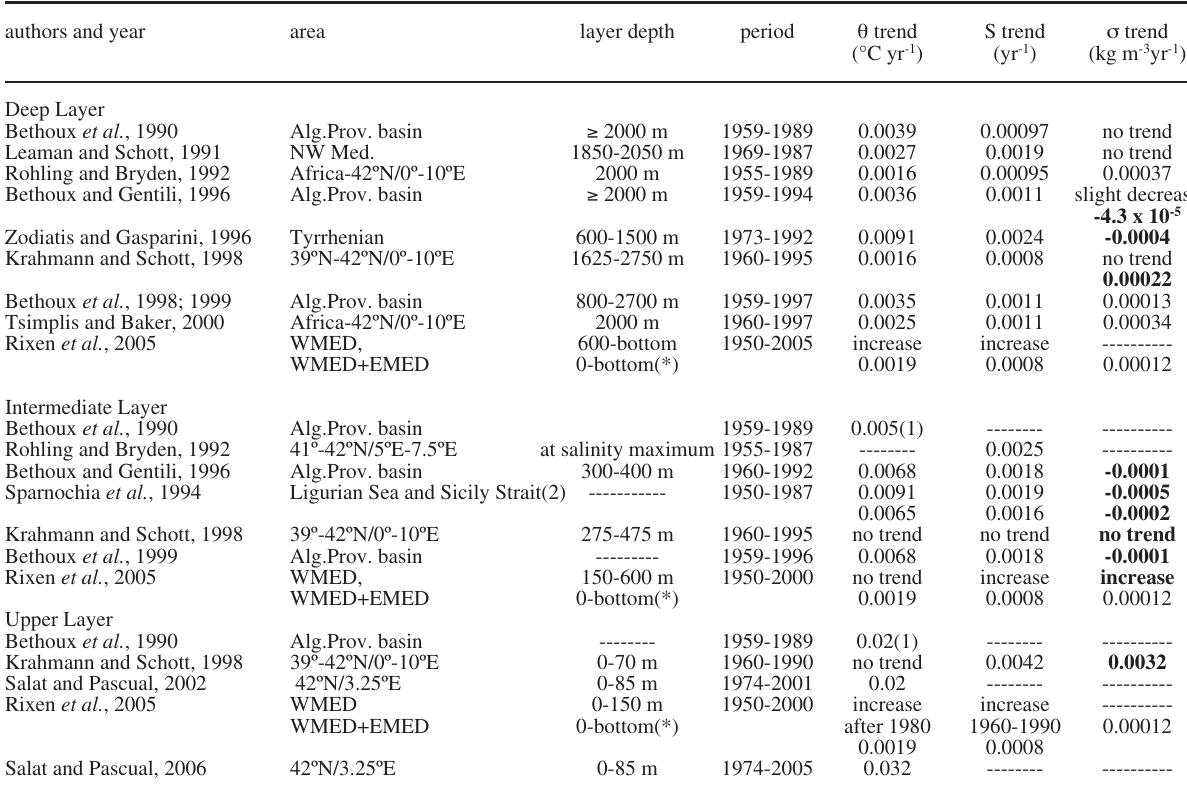
Table 1. – Trends for the WMeD from the literature. alg. Prov. stands for algero-Provençal. (1) estimated from volume and heat conser- vation. (2) obtained from Table 3 in bethoux and gentili (1999). Dashed lines indicate that the authors do not provide the corresponding information. in some papers trends are provided in the original papers at a qualitative level. Density trends are not given for some layers by some authors. Figures in bold have been calculated from the temperature and salinity trends using Dr = r [aD T + bD S ] . (*) rixen et al. (2005) 0 provide volume mean Ts increases. as these increases represent an average of the changes for the upper, intermediate and deep layers, they are included in the three layers as a reference. authors and